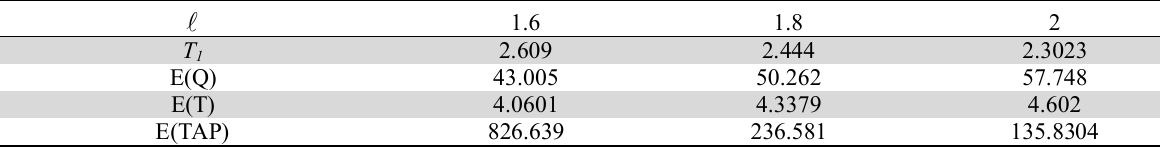
Effect of  on optimal values